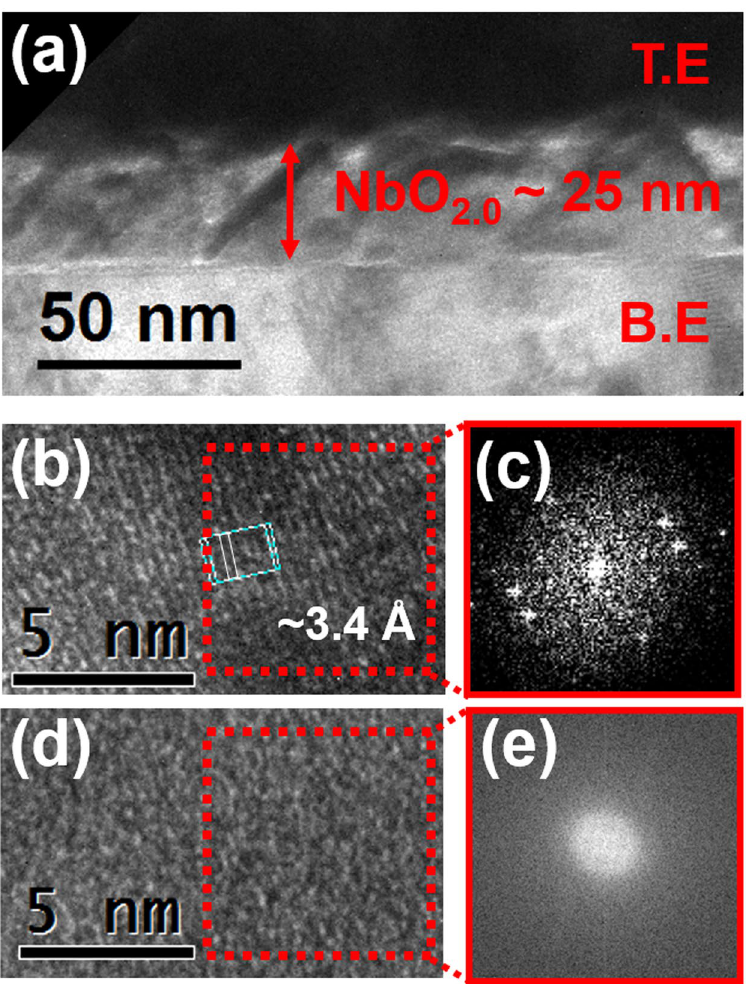
Figure 1. ( a ) Overall TEM image of device structure of MBE deposited NbO 2 film. Thickness was about 25 nm. ( b ) HRTEM image and ( c ) FFT image of MBE deposited NbO 2 film which has poly-crystalline state. The lattice constant was about 3.4 Å and it was corresponding with (400) direction of NbO 2 . ( d ) HRTEM image and ( e ) FFT image of sputter deposited NbO x film shows that it has purely amorphous